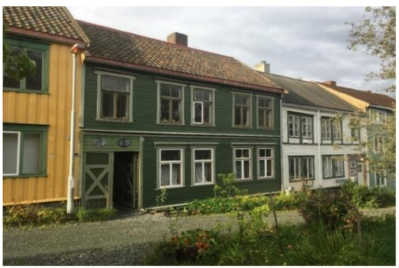
Figure 4. Svartlamon wooden buildings